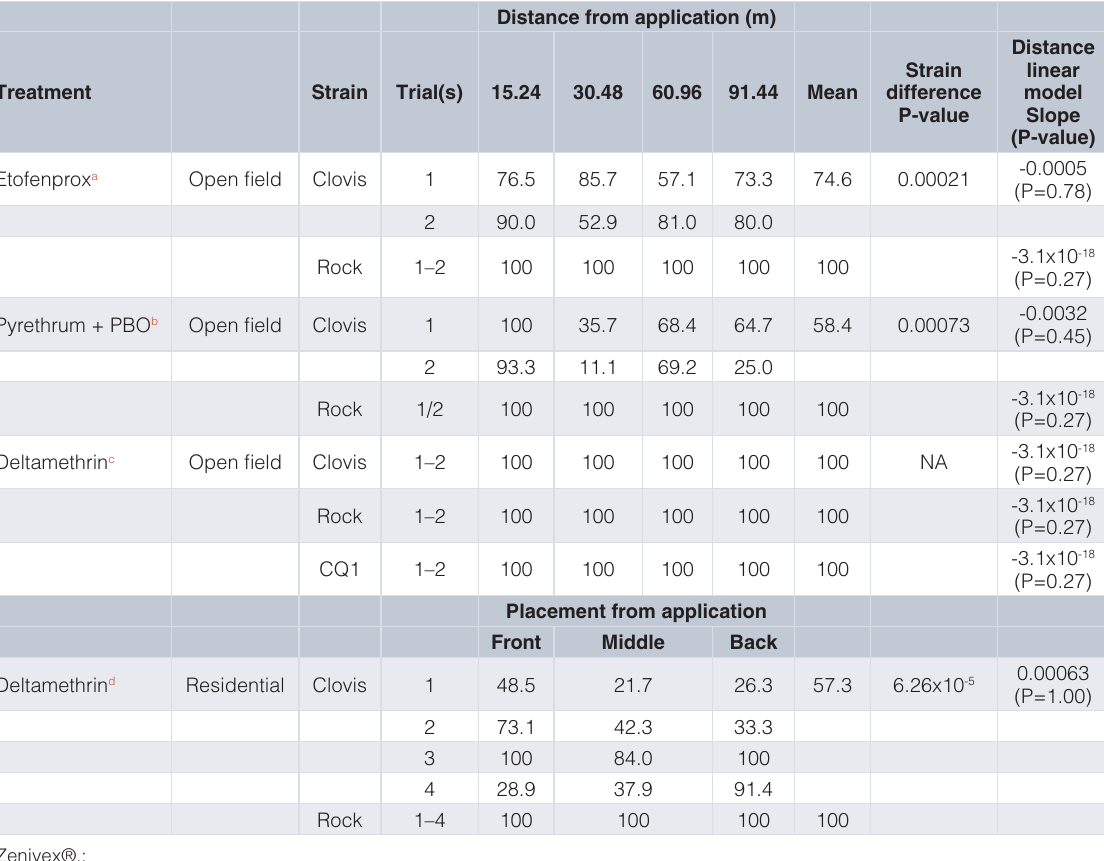
Table 1. Percent mortality recorded 12 hours after exposure to ULV insecticide in open and residential settings. Zenivex® was applied at 4g/ha, MGK Pyrocide® at 60g/ha and DeltaGard® at 1.5g/ha. A temperature inversion of 1°C and